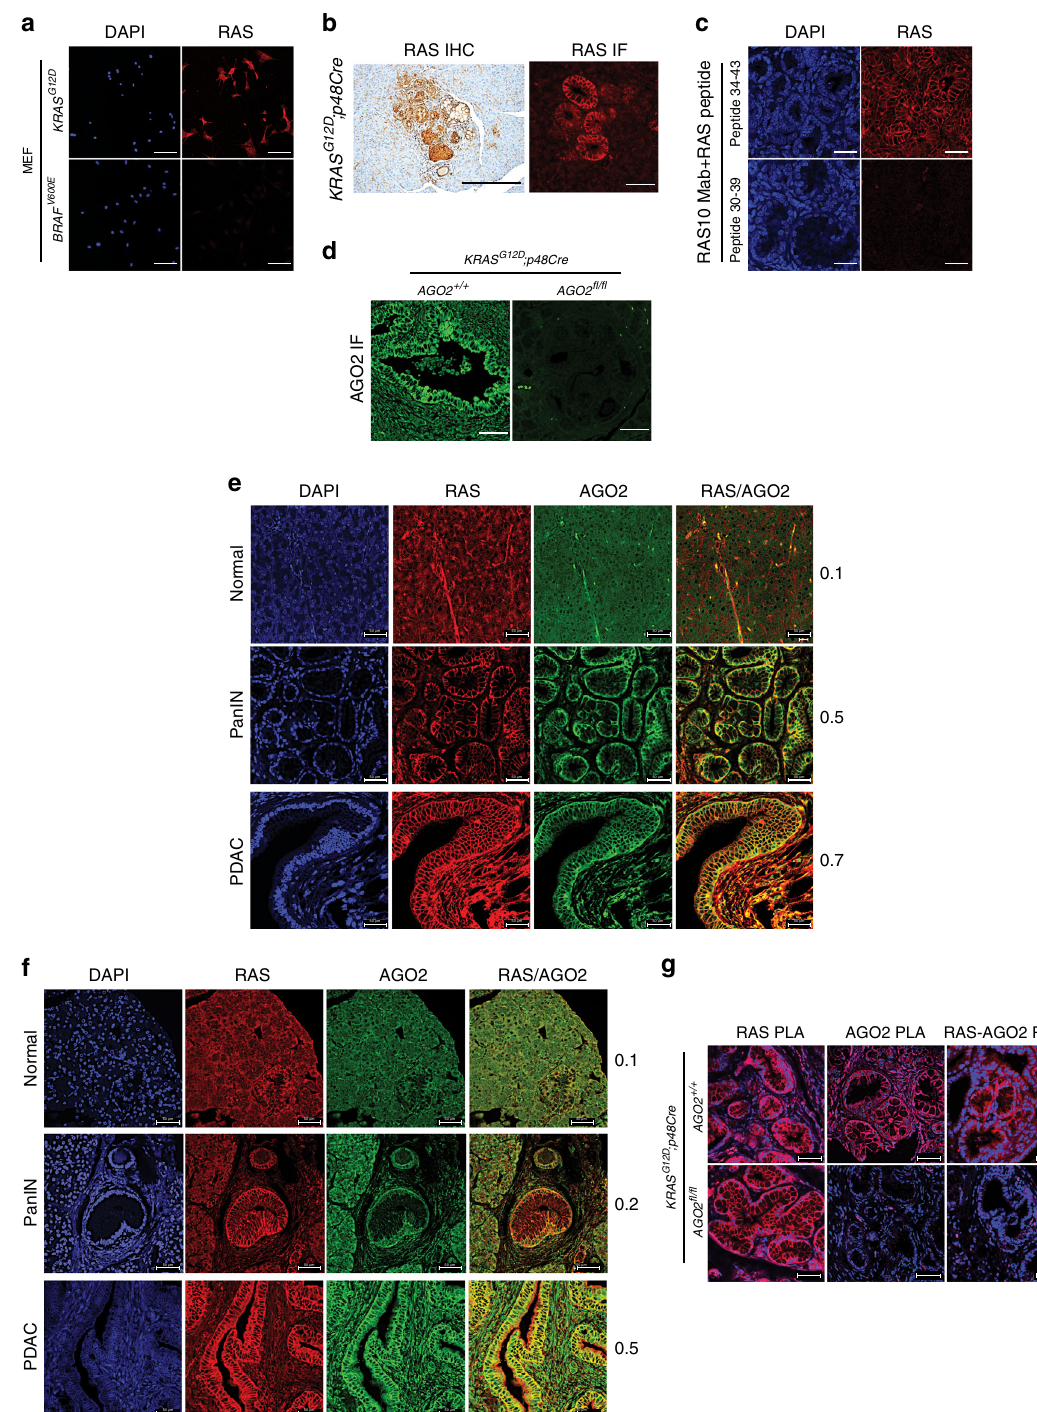
inhibit AGO2 function through phosphorylation of its tyrosine 393 residue 12 . Immunoblot analysis of pancreatic tissues from 12- week-old mice with AGO2 + / + ;KRAS G12D ;p48Cre , AGO2 fl / + ; KRAS G12D ;p48Cre , and AGO2 fl / fl ;KRAS G12D ;p48Cre genotypes showed a marked increase in AGO2 levels relative to normal pancreata (Supplementary Fig. 12a) concordant with IF analysis (Fig. 5e). Consistent with published studies 7,8 , total EGFR levels were also elevated in KRAS G12D mice irrespective of the AGO2 genotype (Supplementary Fig. 12a). However, in early PanINs initiated by oncogenic KRAS, signi fi cantly higher levels